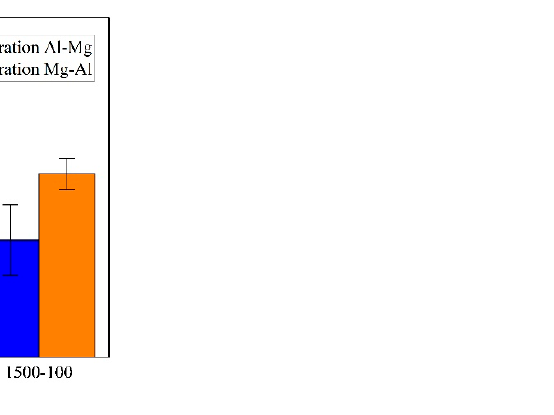
rotation speeds. rotation